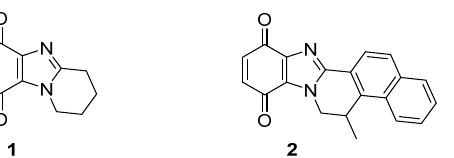
Figure 4. Benzimidazolequinones targeting over-expressed reductases in solid tumors [21–23].